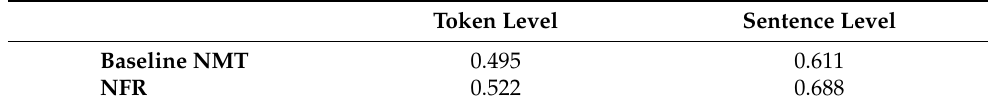
Table 3. Kappa scores for IAA on error